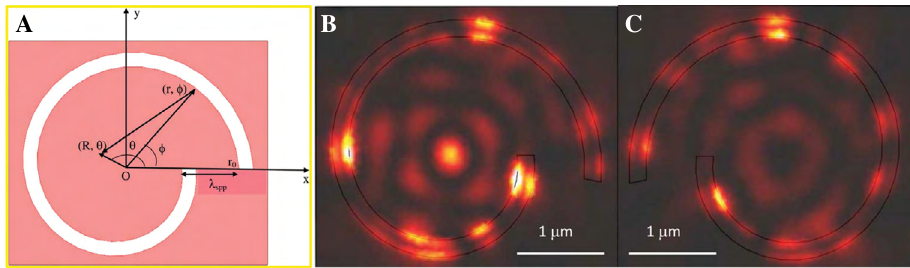
Figure 17 (A) Diagram of a LHS and the coordinates used in the calculation. Simulation results of the intensity distributions on (B) LHS and (C) RHS under RHC polarization illumination. Adapted from Ref. [41].